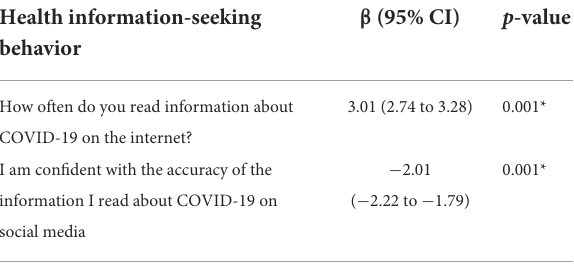
TABLE 5 Linear relationship between overall DHL and health information-seeking behavior ( n = 301).